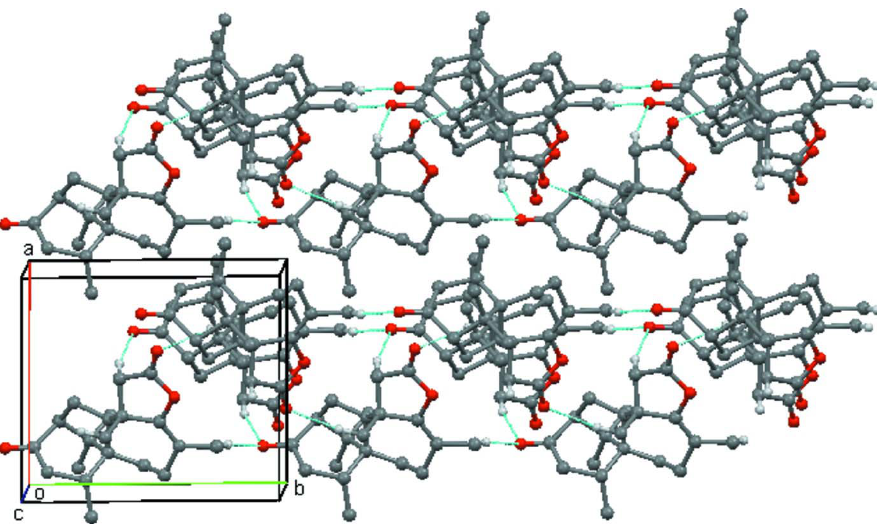
Figure 3 Showing the connection of the adjacent screw chains by C—H···O weak interactions. Only H atoms involved in hydrogen bonds were shown for clarity. Hydrogen bonds are shown as dashed